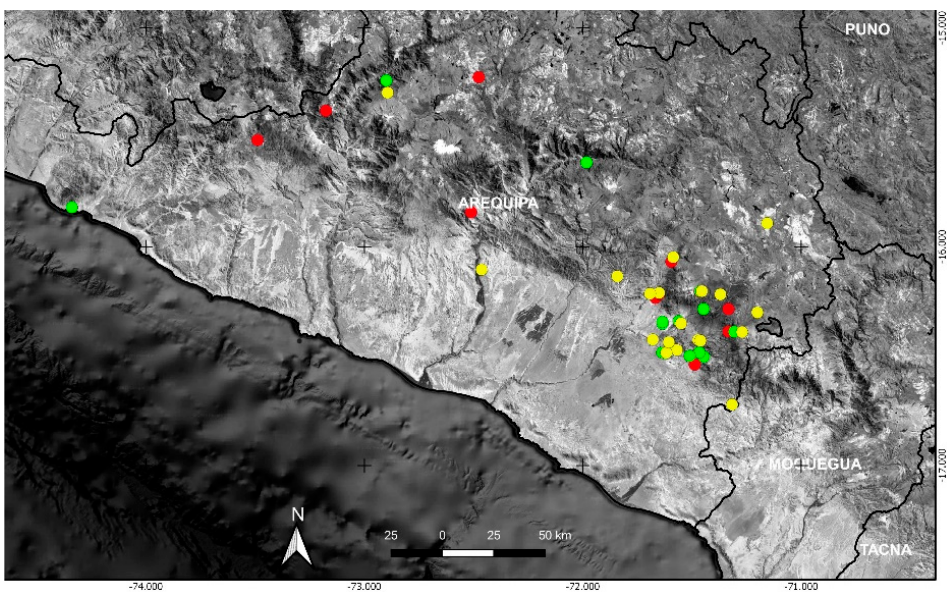
Figure 8. Distribution of Diplostephium meyenii (red dots), Gochnatia arequipensis (green dots), and Senecio yurensis (yellow dots) in Arequipa Region.